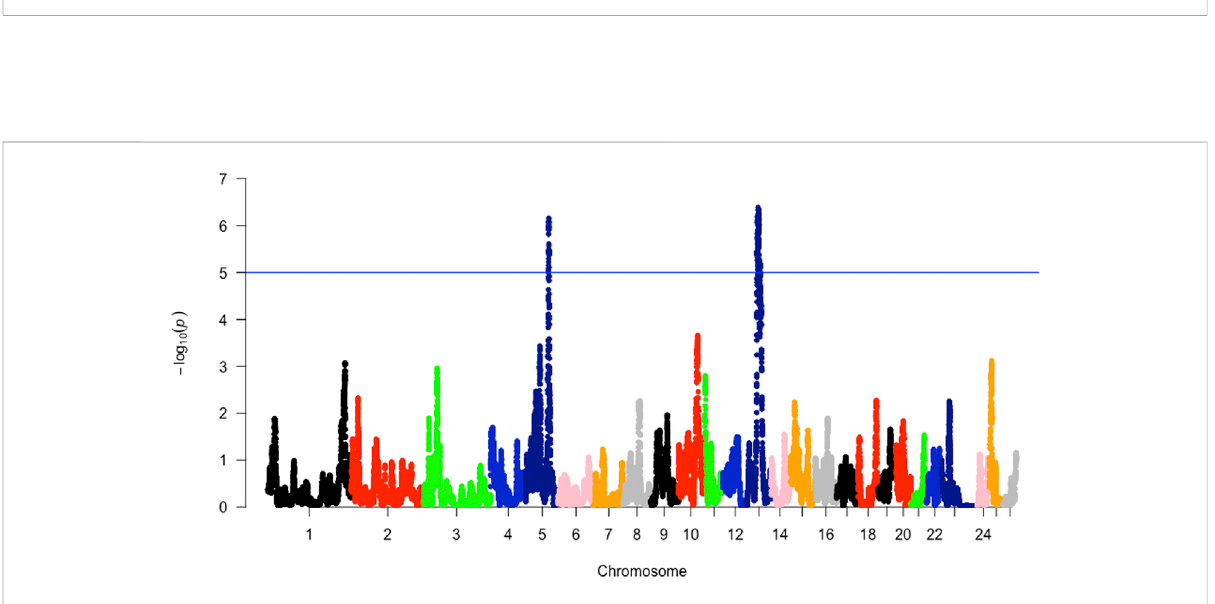
FIGURE 6 hapFLK scores of Merino-derived breeds against presumed